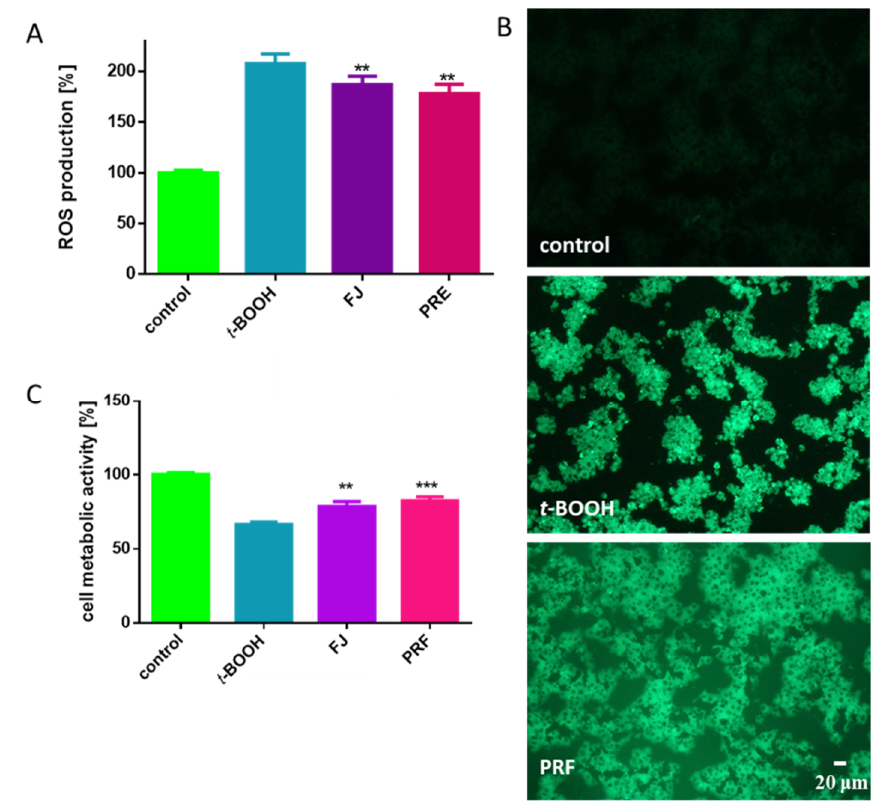
Figure 6. The cytoprotective properties of V. opulus extracts at IC 0 dosages (24 h pre-incubation) against chemical induction (500 µM t- BOOH, 2 h) and oxidative stress analyzed by DCFH-DA on MIN6 cells ( A ); cells visualized under fluorescent microscope: low fluorescence in control cells, very high fluorescence in cells after incubation with 500 µM t -BOOH, and decreased in cells pre-treated with PRF for 24 h before t -BOOH addition (200 × magnification) ( B ); MIN6 metabolic activity analyzed with PrestoBlue assay ( C ). Control cells were not exposed to any compound but the vehicle; values are means ± standard deviations from at least three independent experiments, n ≥ 12; statistical significance was calculated versus cells treated with t -BOOH, ** p ≤ 0.01, *** p ≤ 0.001.